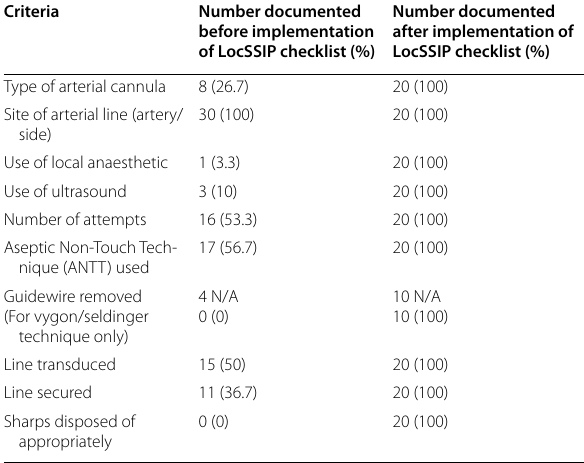
Table 1: Documentation of essential criteria for arterial line insertion before and after LocSSIP checklist implementation Conclusion. Introduction of a Local Safety Standard for Invasive Procedures (LocSSIP) for arterial line insertion led to improved docu- mentation of all criteria. We aim to repeat the audit yearly in order to ensure compliance. Reference(s)